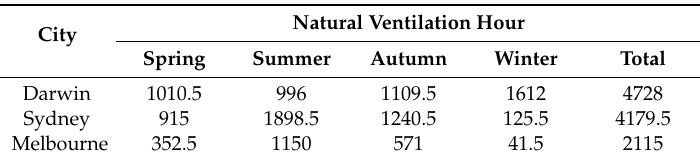
Table 2. Natural ventilation potential under different